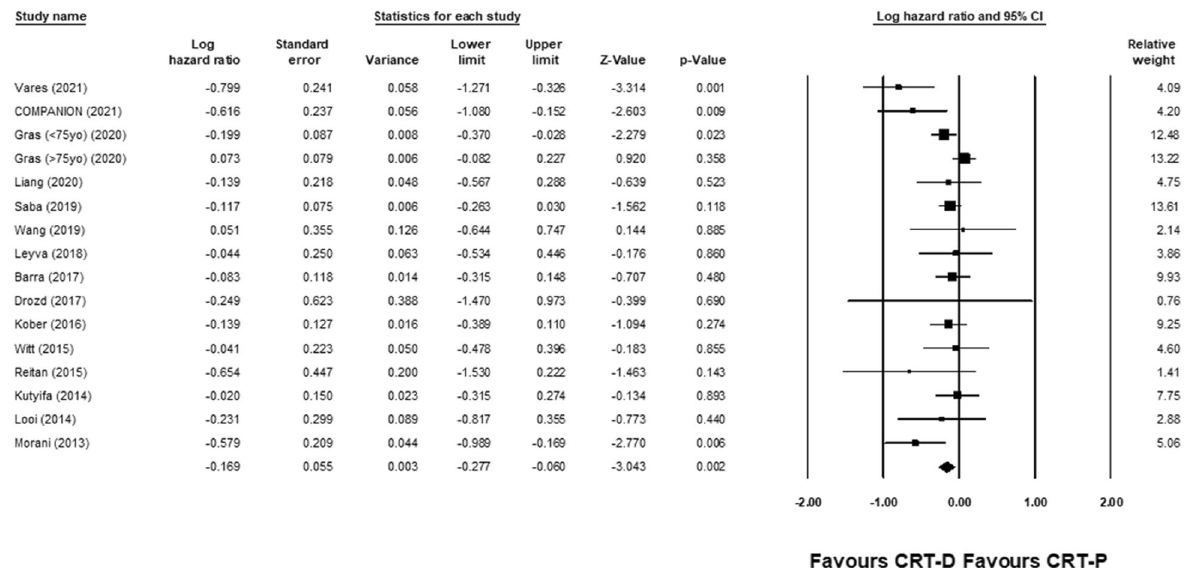
Fig. 2 Forest plot demonstrating impact of CRT‑D on long‑term (> 1 year) mortality in patients with NICM compared to CRT‑P. In patients with NICM and indication for CRT and ICD: CRT‑D was associated with lower all‑cause mortality (log HR Heterogeneity: df